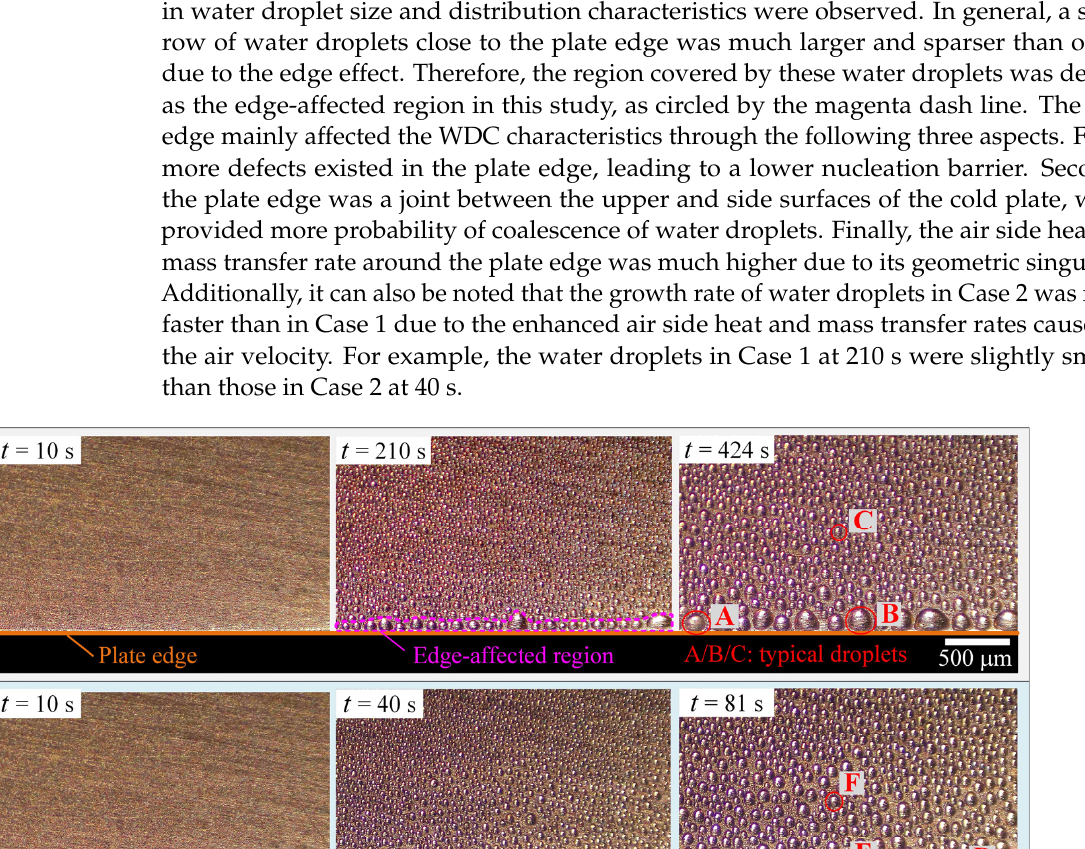
Figure 3. Droplets B and E represented water droplets in the edge-affected regions in